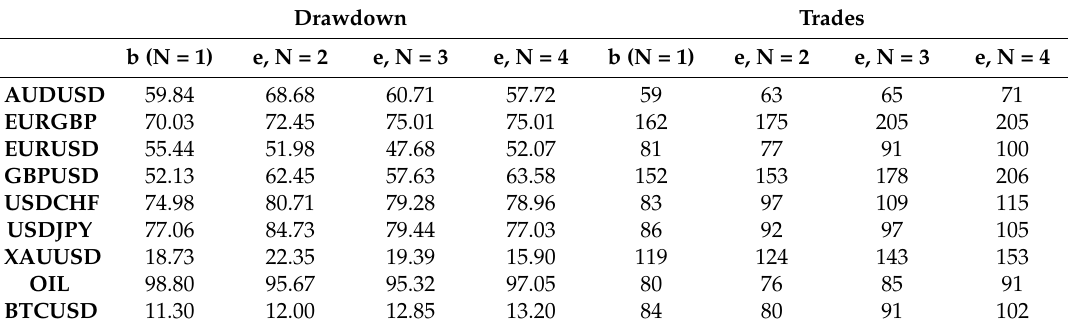
Table A6. Additional results of experiment (e) for various values of